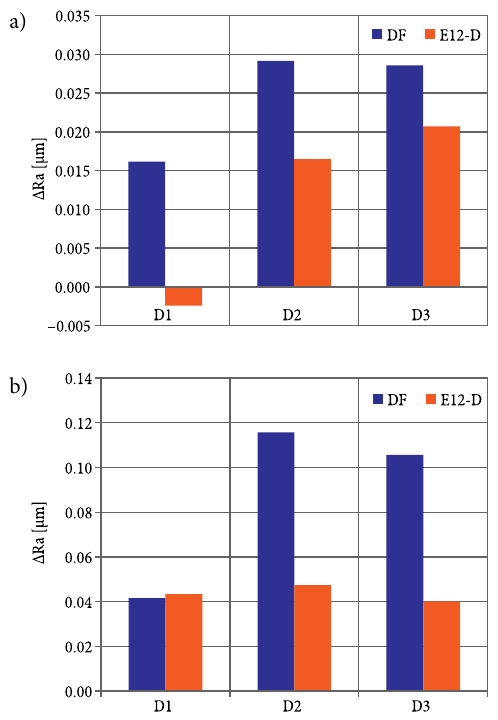
Fig. 5. Barrels surfaces D R a and D R z values for both tested fuels